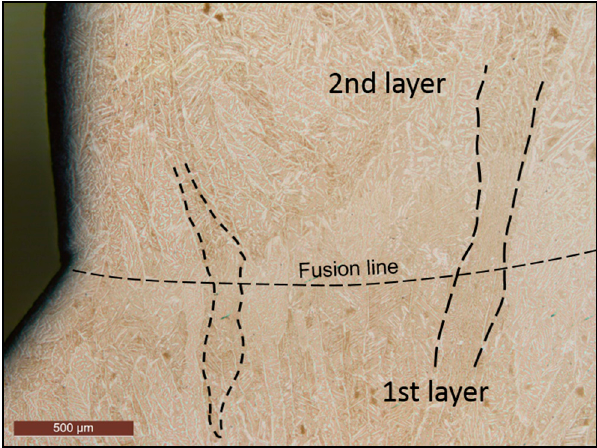
Figure 11. Micrographs with indications of epitaxial solidification (one example is shown inside black dotted lines); between first and second build layer (0.87 kJ/mm).